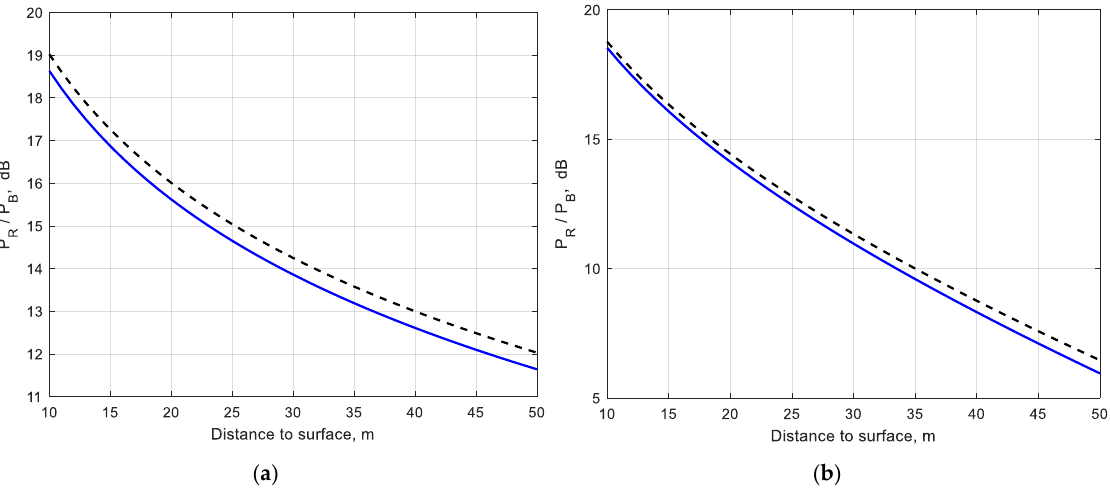
Figure 6. Scene-to-brownout backscatter ratio vs. distance to surface; solid line ( ― ) — (23), (27) with Mie solution; dashed line ( ‒ ‒ ) — (23), (27) with Rayleigh approximation. Surface reflectance: ρ = 0.15;